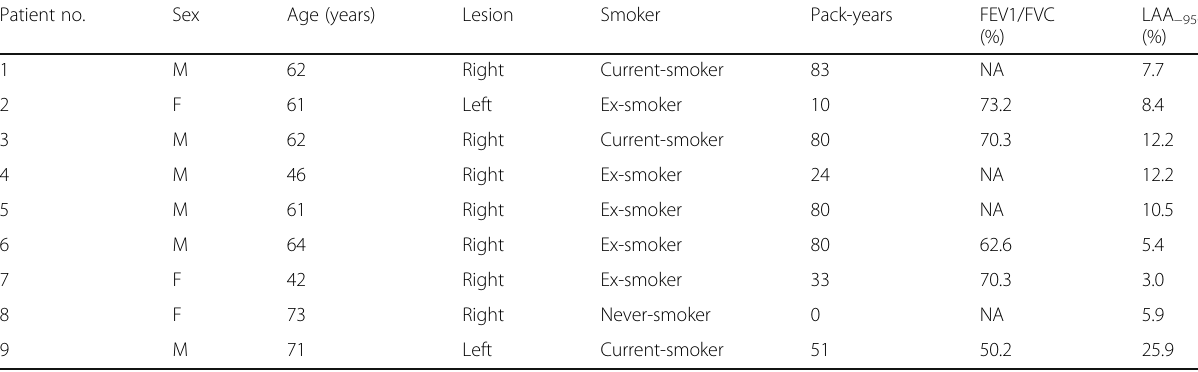
Table 1 Patient characteristics Patient